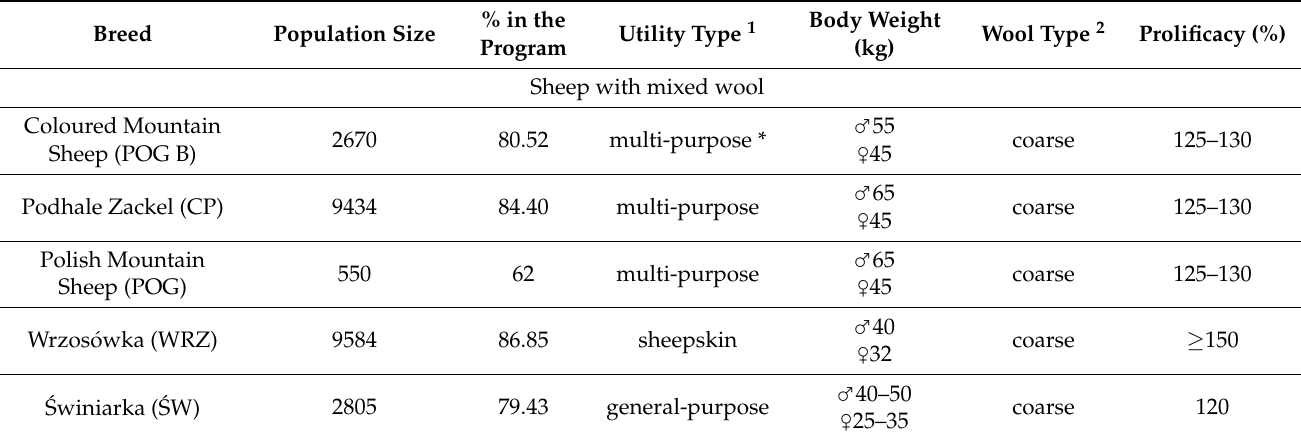
Figure 1. Main regions of origin and occurrence of native breeds of sheep in Poland—Pomeranian (POM), Kamieniecka (KAM), Wrzosówka (WRZ), Black-headed (CZG), Ż ela ź nie ń ska ( Ż EL), Uhruska (UHR), Corriedale (KOR), Ś winiarka ( Ś W), Coloured Mountain Sheep (POG B), Polish Mountain Sheep (POG), Podhale Zackel (CP), Olkuska (OLK), Polish Pogórza sheep (PG), Wielkopolska (WLKP), White-headed meat sheep (BOM), Old-type Polish Merino (MST), Coloured Merino (MB). Table 1. Characteristics of Polish native breeds of sheep, divided into utility groups.